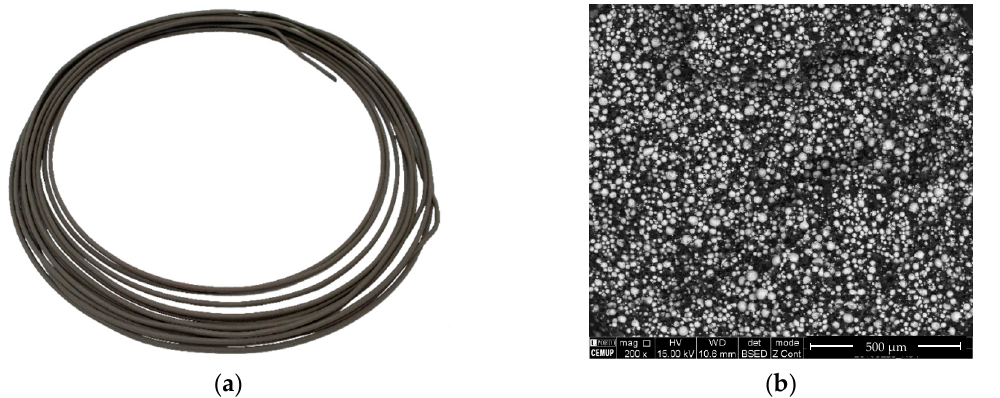
Figure 5. ( a ) Extruded filament of prealloyed NiTi; ( b ) metallic powder particle distribution in the